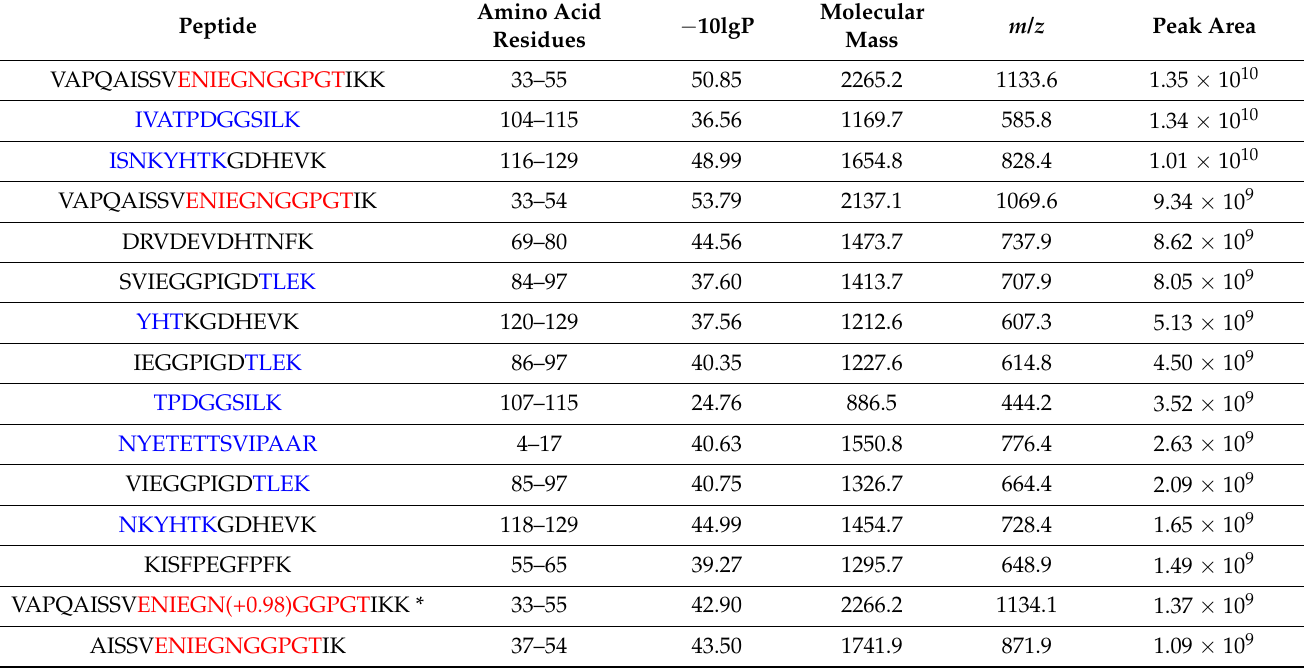
Table 1. The most represented proteolytic fragments (peak area > 1.0 × 10 9 ) of Bet v 1 identified using LC-MS/MS after the birch allergen Bet v 1 degradation for 8 h in vitro by lysosomal enzymes of human macrophages. Red color shows amino acid sequence of the dominant linear IgE-binding epitope of Bet v 1 42–52 [29]. Blue color shows fragments of the linear T-cell epitopes of Bet v 1 [28].